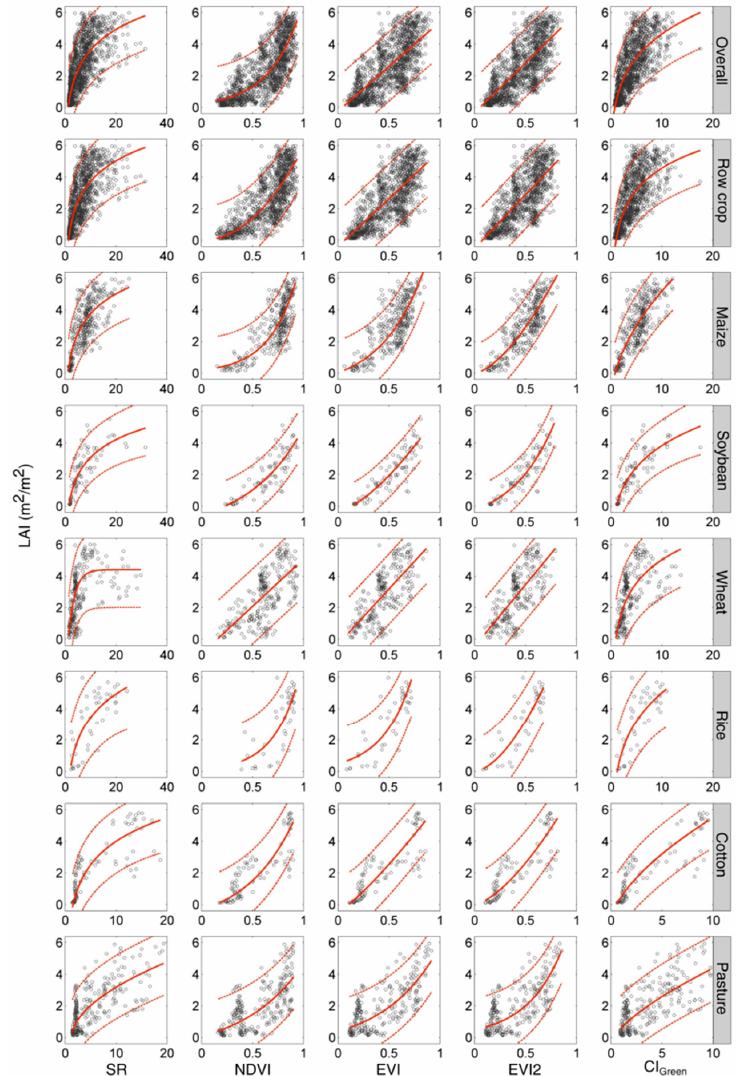
Figure 3. Best-fit functions of global LAI-VI relationships based on in situ LAI and surface reflectance based VIs (Simple Ratio (SR), Normalized Difference Vegetation Index (NDVI), Enhanced Vegetation Index (EVI), EVI2, and Green Chlorophyll Index (CI Green )) for the overall dataset as well as different crop types. Best-fit functions are plotted by solid red lines, and prediction intervals (95%) are presented in dashed red lines. Note that all the curves are fitted in the form of LAI “ f p VI q , although in this figure, LAI is plotted on the X axis instead of the Y axis to better address the saturation issue of the normalized VIs (NDVI, EVI, and EVI2).